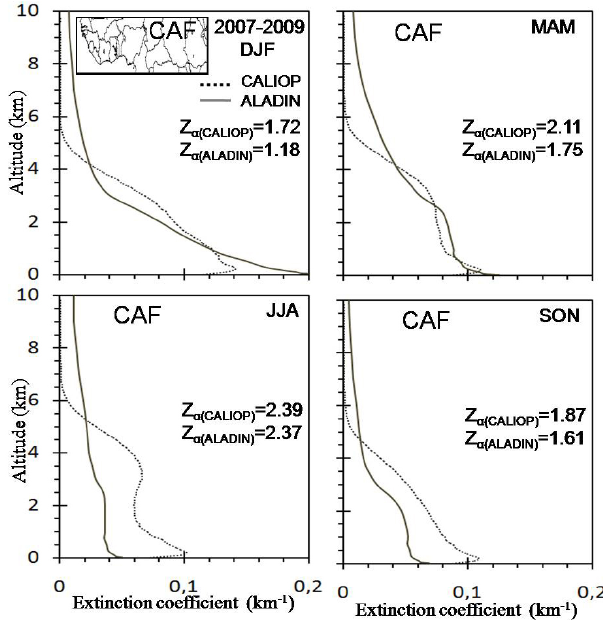
Figure 16. CALIOP and ALADIN mean seasonal extinction coeffi- cient (km − 1 ) profiles (at 532 and 550nm, respectively) averaged from 2007 to 2009 over central Africa (CAF). CALIOP profiles are shown as dark dashed lines and ALADIN profiles are shown as continuous grey lines. For each season, we give the Z α value for CALIOP and